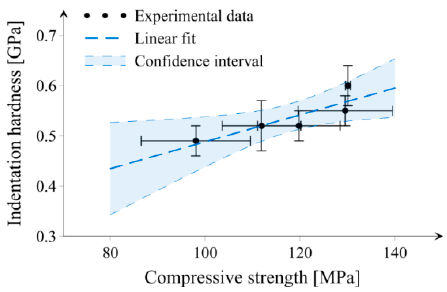
Figure 11. The relation between compressive strength and indentation hardness for all investigated sample series. Horizontal and vertical bars indicate one standard deviation.